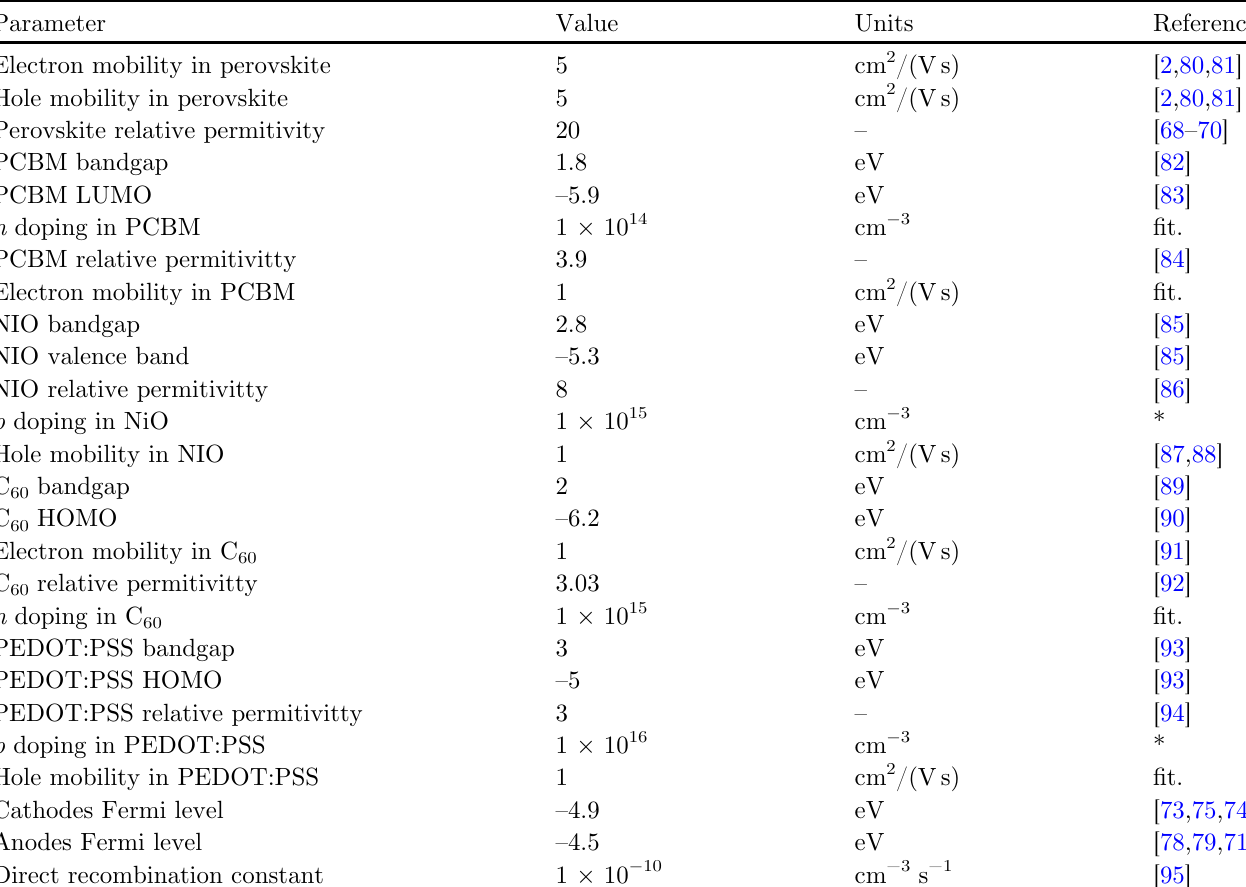
Table 1. List of parameters used in the drift-diffusion simulation. Parameters marked with asterisks (*) are varied during the simulations. In case of multiple references, approximated values are chosen from the gives